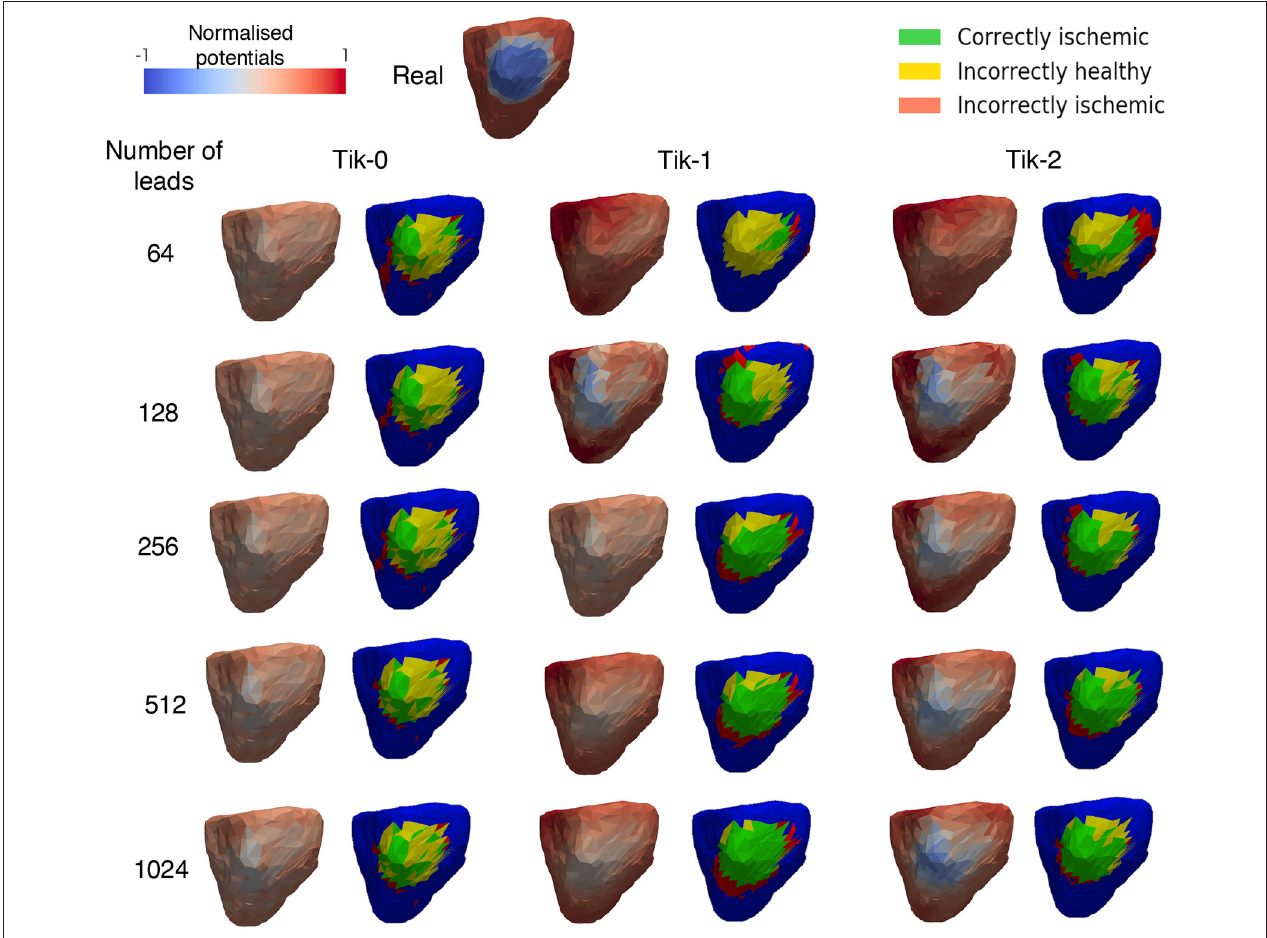
FIGURE 5 | Reconstructed epicardial excitation pattern from the right lateral view of the ventricle at 100ms. Each regularisation column has two sub columns, (Left) is the reconstructed epicardial potential and (Right) is a “traffic light” diagram coloured according the ischemia detection results. Green areas represent the successful identification of the ischemic lesion, yellow areas are ischemic which were not identified, and red areas indicate areas incorrectly identified as